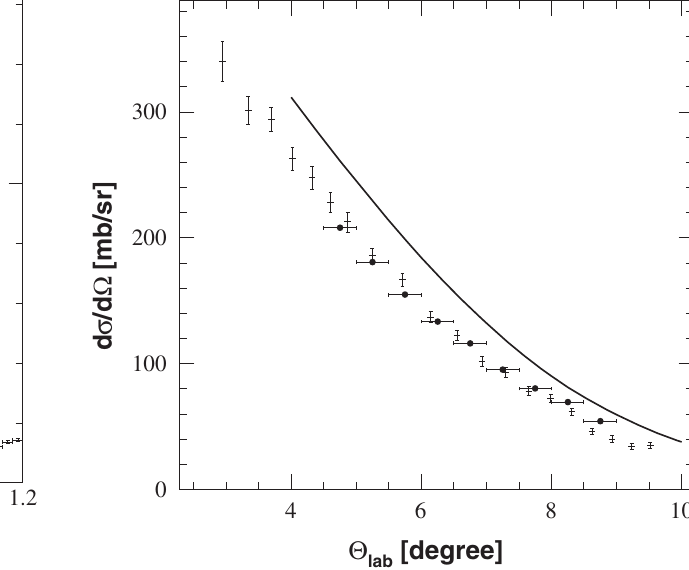
FIG. 10. Laboratory differential cross section for elastic proton-proton scattering at 2.65 GeV. Our points, shown by closed circles with bin widths, have systematic uncertainties of (cid:5) 12% , as shown in Table III. The curve is the SP07 solution from the SAID analysis group [15,16] and the crosses are experimental data at 2.83 GeV [18].